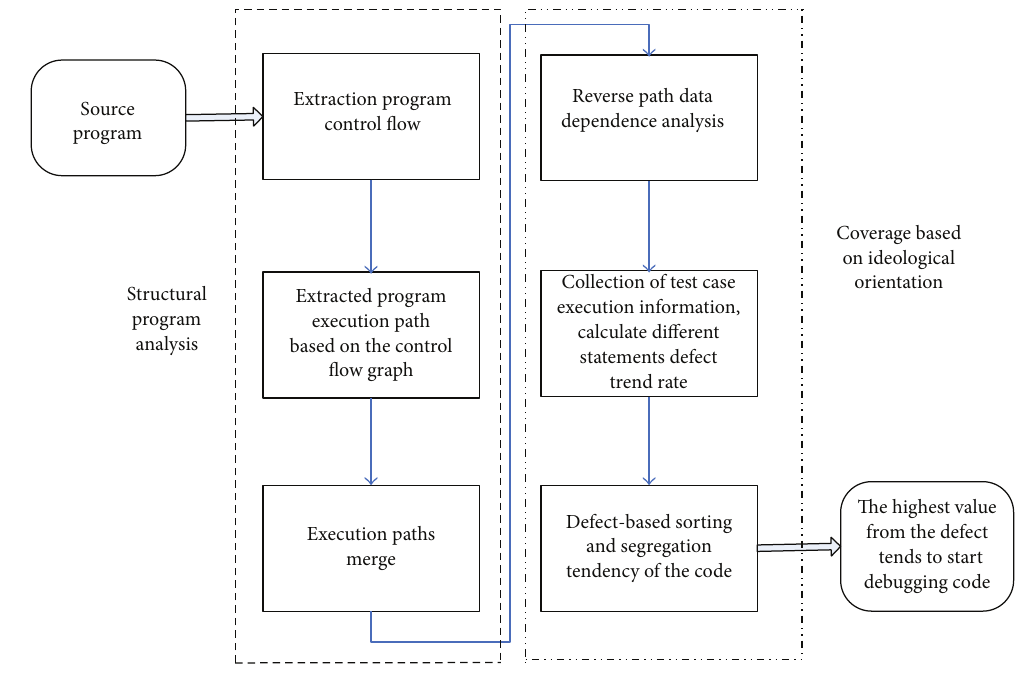
Figure 4: Basic idea description block diagram.